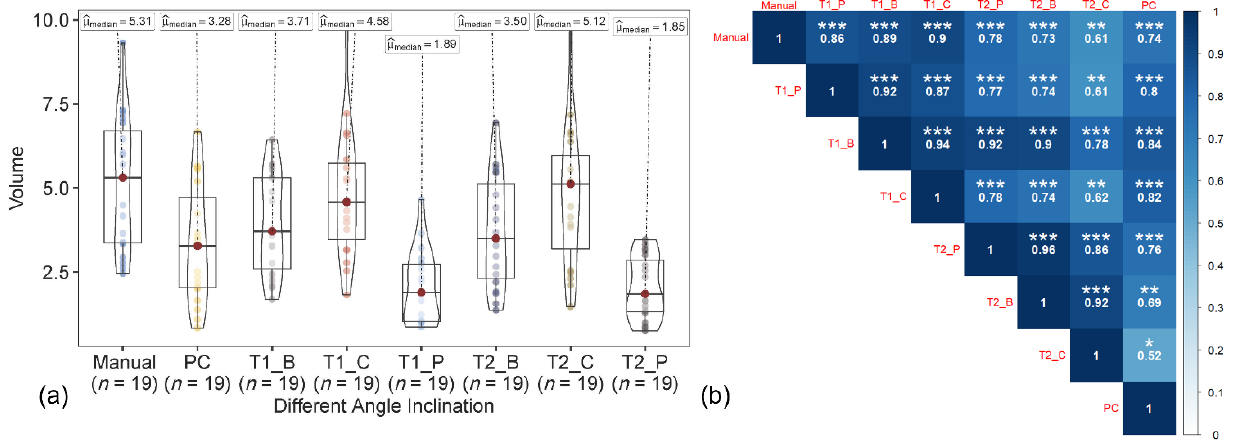
Figure 11. ( a ) Violin box plot showing the canopy crown volume range (m) and the ( b ) correlation matrix showing the correlation between ground the reference data and estimated volume with the integrated sensor angle dataset using the T1, T2, and point cloud (PC) UAV-based approaches with canopy area estimated using the polygon, box and circular canopy area. Significant probability level: * 0.05, ** 0.01, and *** 0.001.